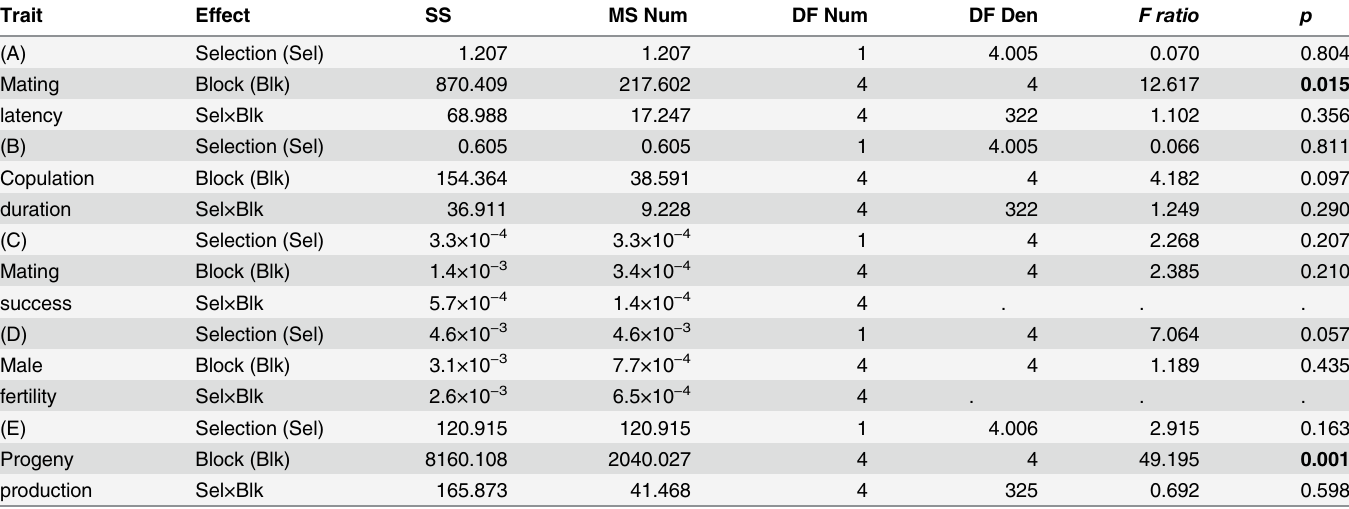
Table 5. Pre- and post-copulatory traits in males not subjected to cold shock. Summary of the results from a two-factor mixed model ANOVA on (A) mating latency (B), copulation duration (C) mating success, (D) male fertility and (E) progeny production. Data considering selection regime (FSB and FCB) as the fixed factors crossed with block (1 – 5) as random factor. p -values in bold are statistically significant.